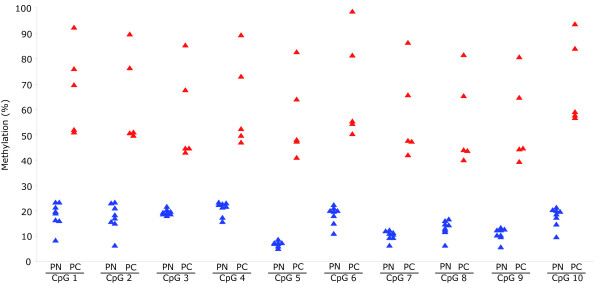
DNA methylation analysis by quantitative bisulfite pyrosequencing. Parathyroid carcinomas (in red; n = 5) and normal parathyroid tissue specimens (in blue; n = 8). Methylation levels were determined for ten CpGs of the APC promoter 1A, in triplicates. See Additional file 1, Table S1 for all measurements.